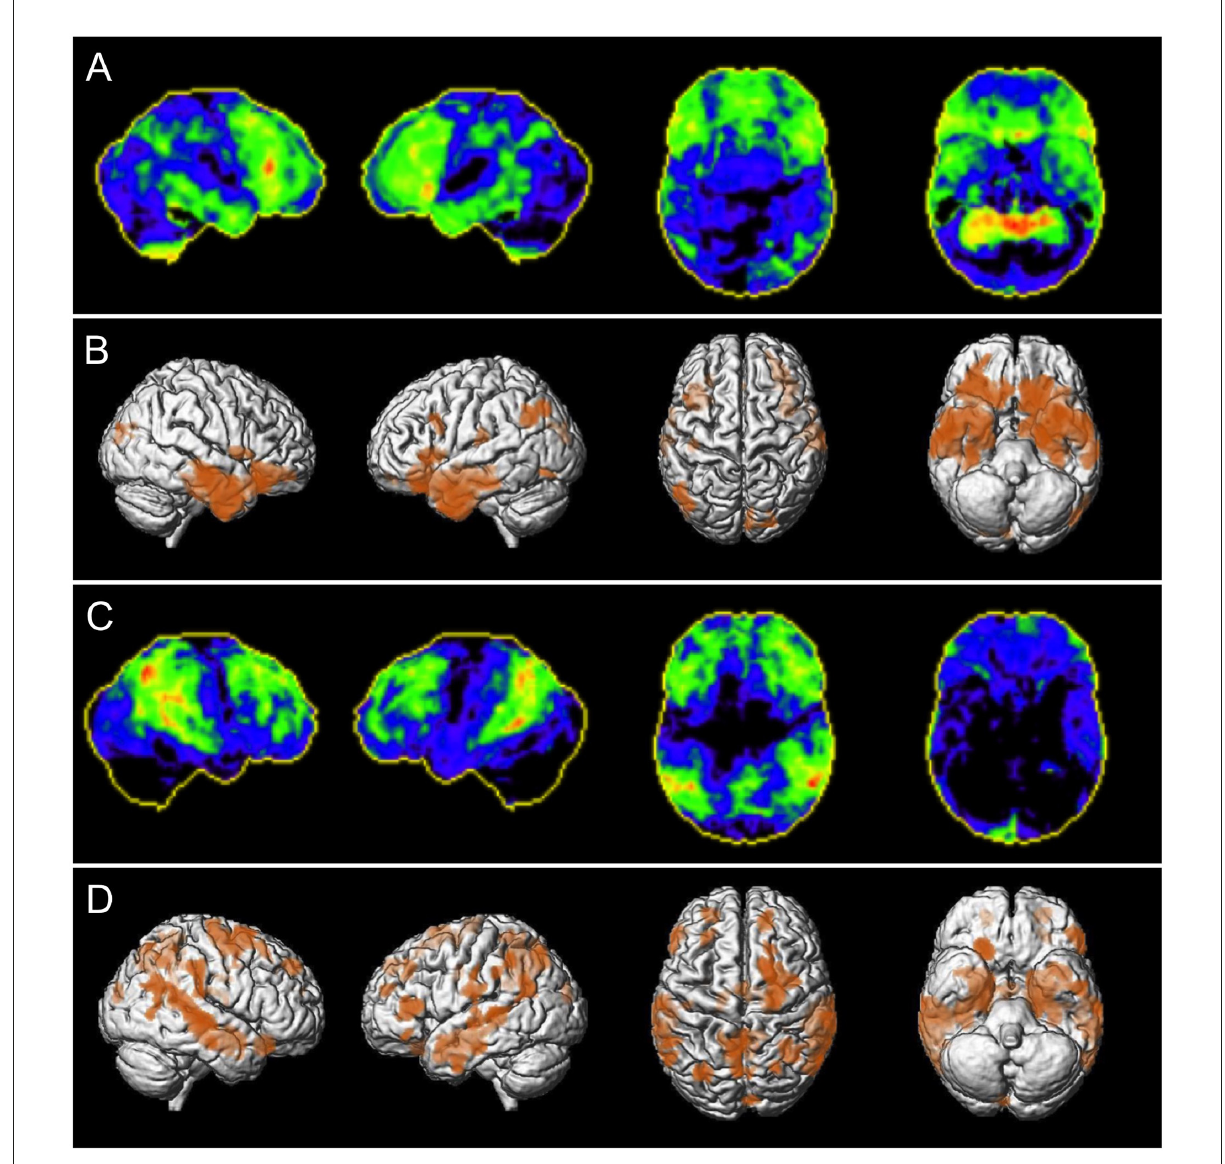
FIGURE2 Patient examples of correctly classified neurodegenerative disease using NBVRs. Panels (A,C) depict negative z-score deviations of FDG-PET imaging using Neurostat (warmer colors represent larger negative z-scores). Panels (B,D) depict 3D renderings of age-adjusted gray matter volume deficits using voxel-based morphometry at p < 0.005 uncorrected. Panels (A,B) show a 70-year-old female patient who was initially falsely evaluated as non-neurodegeneration by both raters and then correctly classified as showing signs of neurodegenerative disease using NBVRs. Panels (C,D) show a 56-year-old male patient who was initially falsely evaluated as non-neurodegeneration by rater 1 and then correctly classified as showing signs of neurodegenerative disease using NBVRs. Abbreviations: NBVR, Normative brain volume